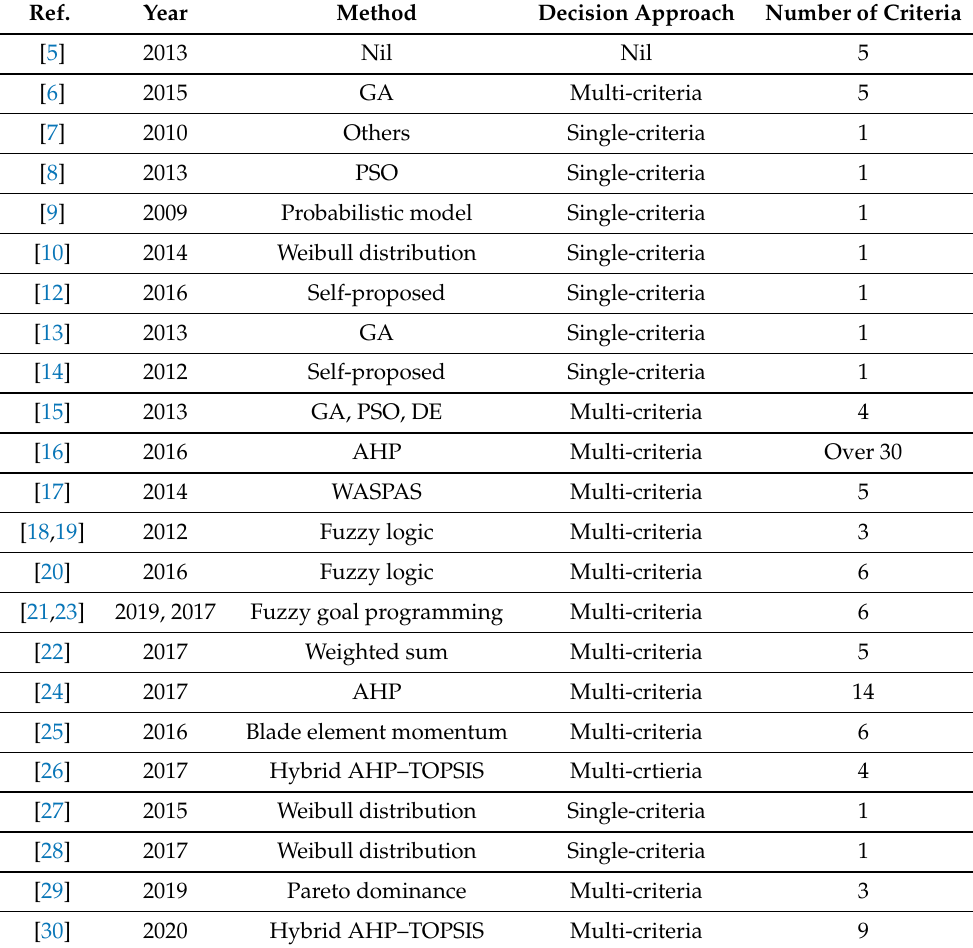
Table 1. Summary of reviewed